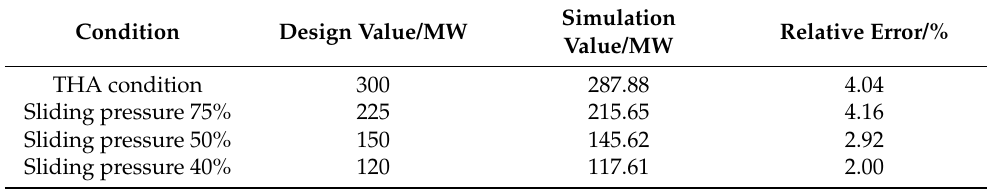
Table 3. Comparison of steam engine thermal parameters under typical working conditions.